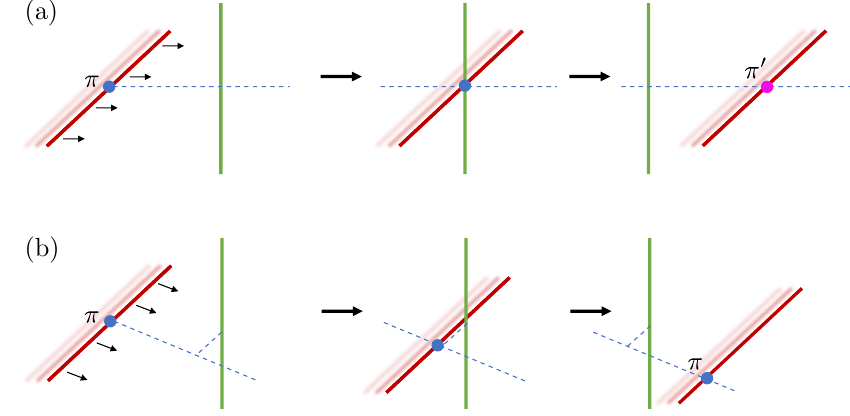
Figure 2: Illustration of the generic properties of a non-topological twist string (green line). There exist a certain flux string with an attached charge π , such that the trans- formation of this charge depends on the detailed geometric trajectory of the flux string and the charge. (a) If the worldline of the attached charge π (blue) intersects with the geometric twist string, the attached charge will be transformed into π ′ (pur- ple). (b) If the worldline of the attached charge avoids the twist string, the attached charge remains the